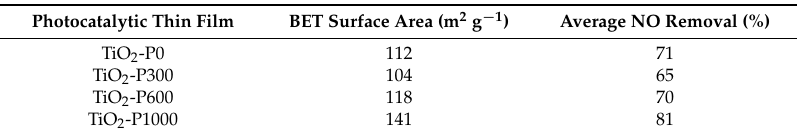
Table 1. Extent of NO removal over 1.0 µ m thick TiO 2 -PX thin films irradiated at 365 nm (illuminated area, 100 cm 2 ; light irradiance, 0.38 mW cm − 2 ) for 12 h in a flow-type reactor (flow rate, 1.5 L min − 1 ; initial concentration of NO, 1.0 ppm; dry